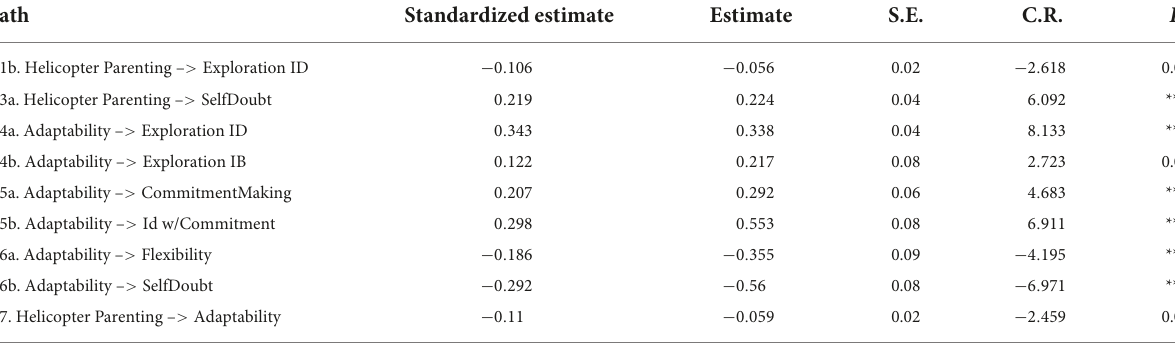
TABLE 2 Summary of standardized and unstandardized regression coefficients for significant